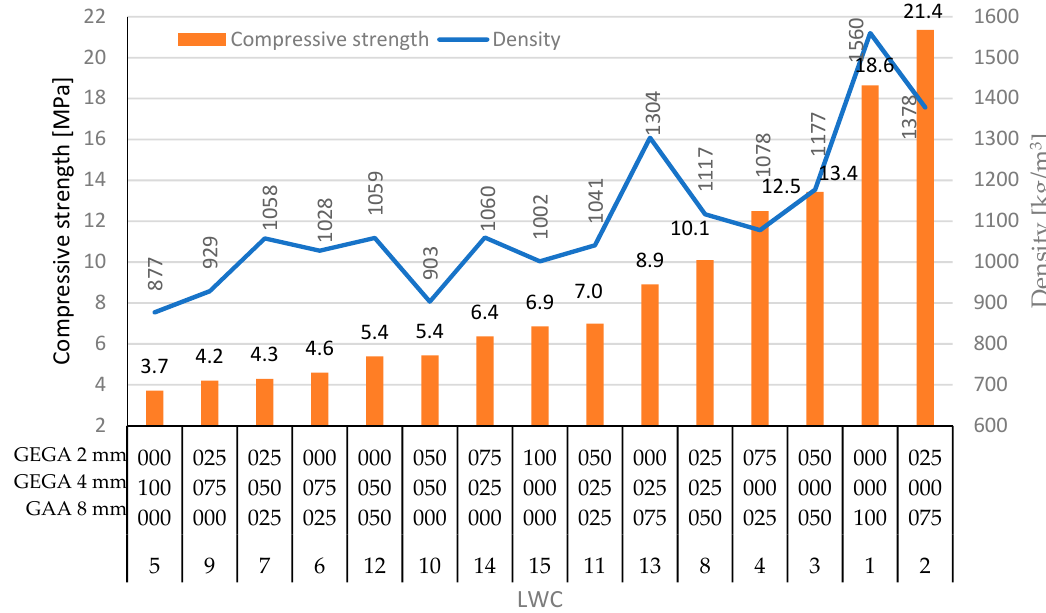
Figure 6. Compressive strength vs. density for LWCs 1–15.